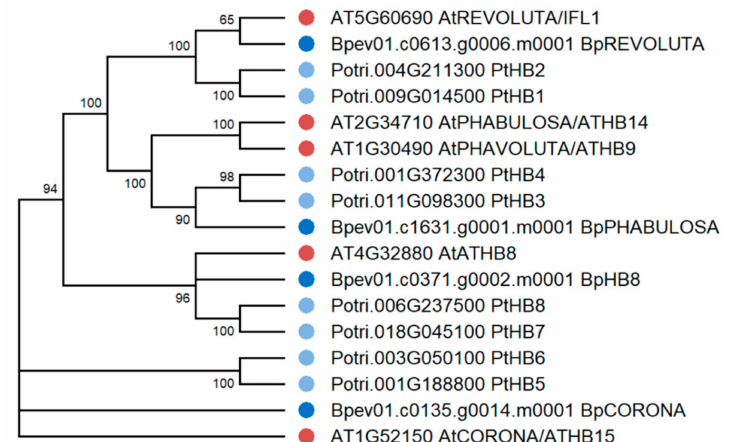
Figure 11. Phylogenetic relationships of HD ZIPs III of B. pendula (dark blue dots), A. thaliana (red dots), and P. trichocarpa (blue dots). Bootstrap values (1000 replicates) are shown next to the branches, and only those values greater than 50 are displayed. The access codes of the A. thaliana and P. trichocarpa proteins in the TAIR and Phytozome databases are indicated next to the corresponding proteins.